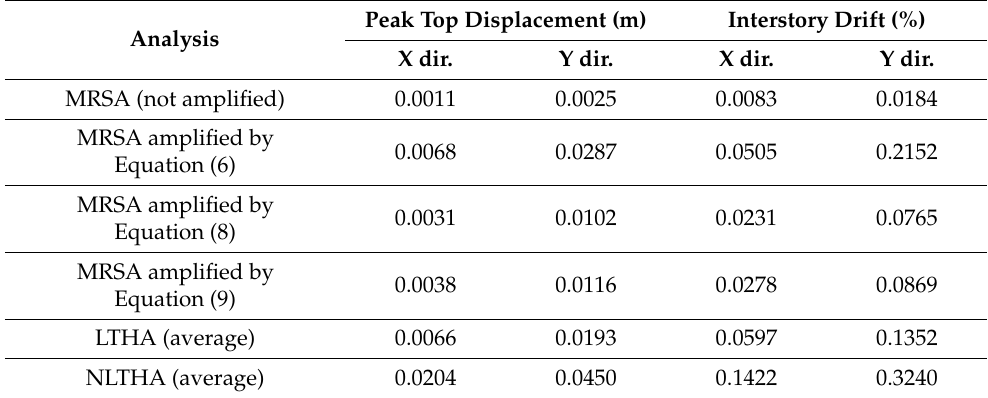
Table 6. Maximum displacement and interstory drift from the analyses in the two directions. Analysis